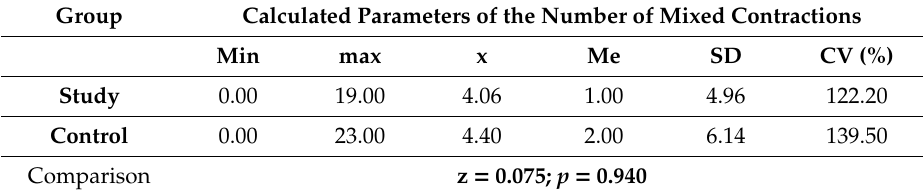
Table 9. Comparison of mean mixed contractions in patients in the study group and in the control group. Group